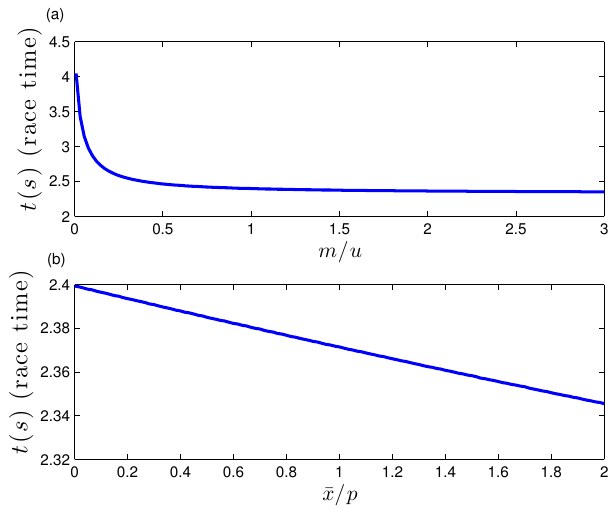
Figure 7. The race time of the car as a function of the car mass (a) and the x-direction location for the car center of mass (b) with parameters given in Table 2 and the normalization constants p = 0 . 09m, and u = 0 . 1091Kg. Beyond a certain mass value the race time barely changes whit increased mass (a).